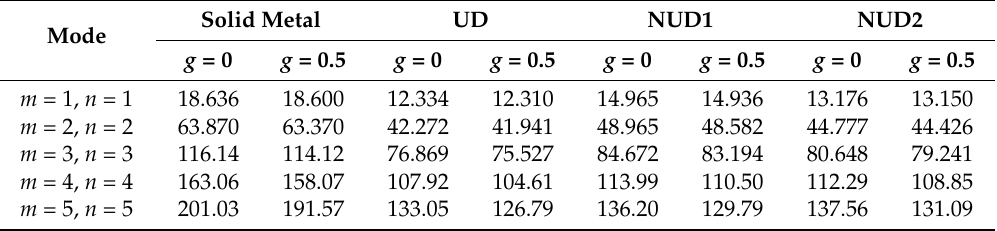
Table 1. The non-dimensional buckling loads with different mode numbers, small scale parameters and porosity distributions of square FG nanoporous nanoplate ( l a = l b = 50 nm, h = 5 nm, ζ = 1, λ = 0.5).